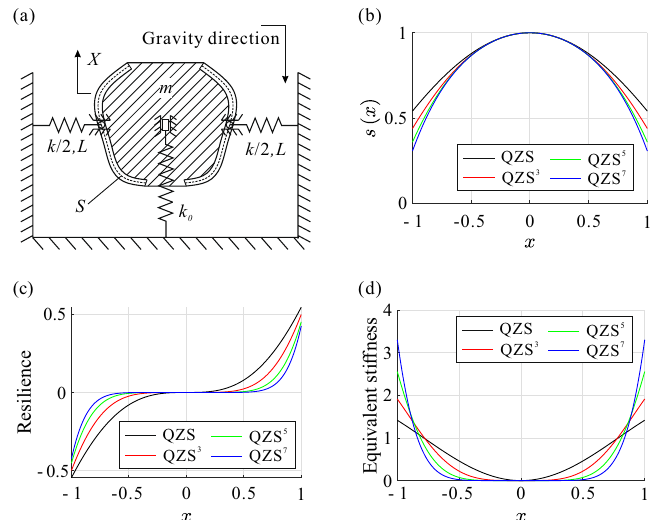
Figure 1. Schematic of the archetypal model and the characteristics under the different order QZS conditions ( a ) for the schematic diagram of the designable model, ( b ) for the dimensionless trajectory curves s ( x ) to construct the QZS, QZS 3 , QZS 5 , and QZS 7 , which are plotted in black, red, green, and blue, respectively,